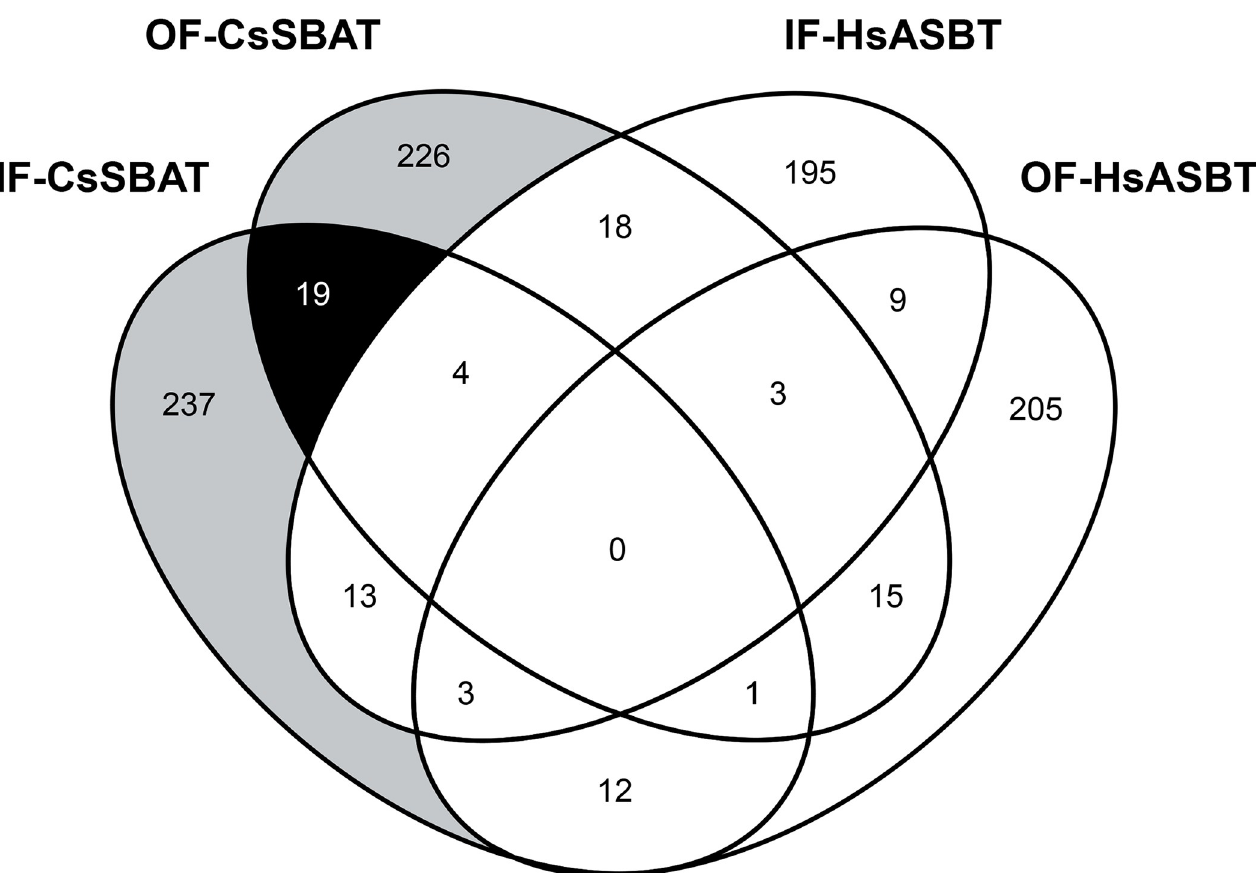
Table 4. Inhibitory compounds subjected to virtual screening using MTiOpenScreen and selected by applying the Lipinski’s rule of five. PubChem Binding energy ID (kcal/mol)